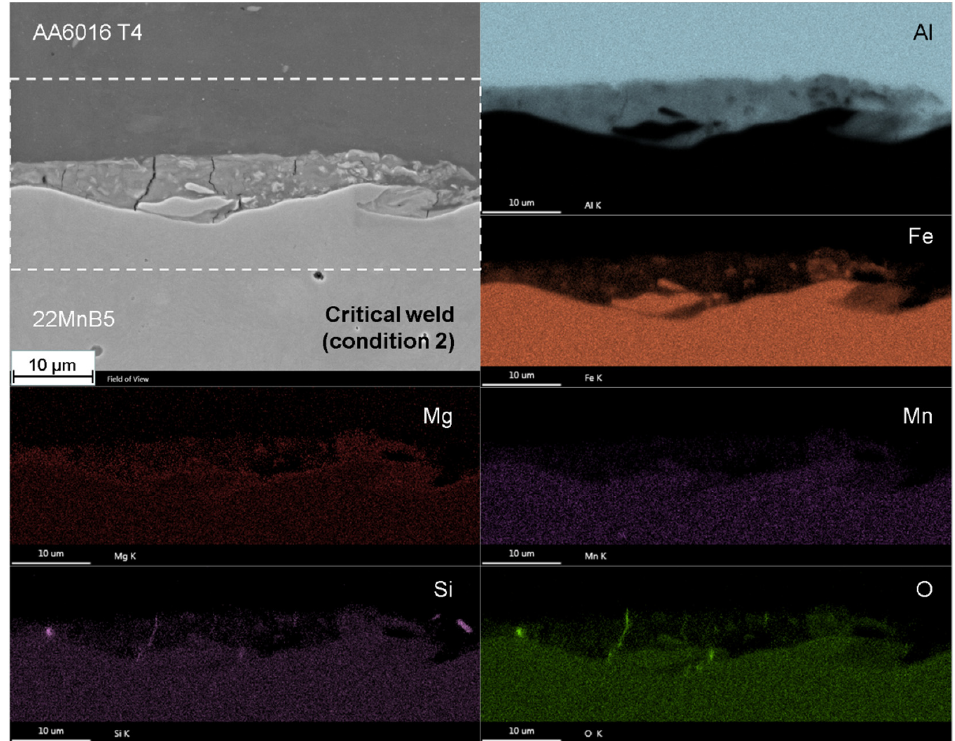
Figure 11. SEM image and EDX mapping of the Al/steel interface area of a critical weld (welding parameters according to condition 2), including the elemental distribution of Al, Fe, Mg, Mn, Si, and O.